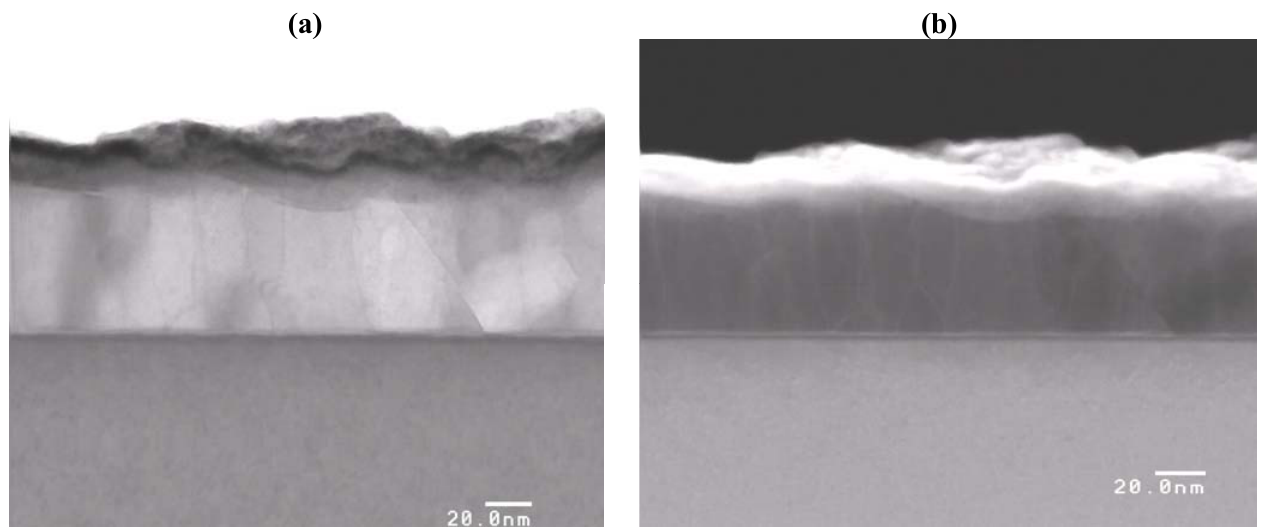
Figure 3. ( a ) Bright field image; and ( b ) HAADF image of as-deposited Pd capped Mg thin film observed by STEM.